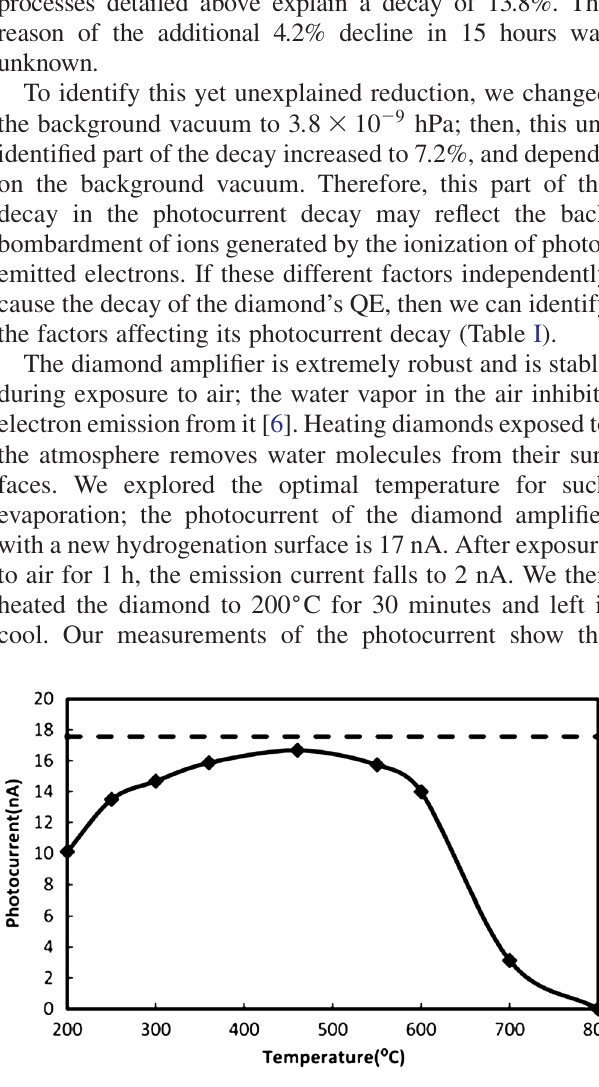
FIG. 4. Temperature scanning for optimizing heat treatment of the diamond. The dashed line is the photocurrent of a freshly hydrogenated diamond. The solid curve is the photocurrent after heating the sample to the temperature indicated and allowing it to cool